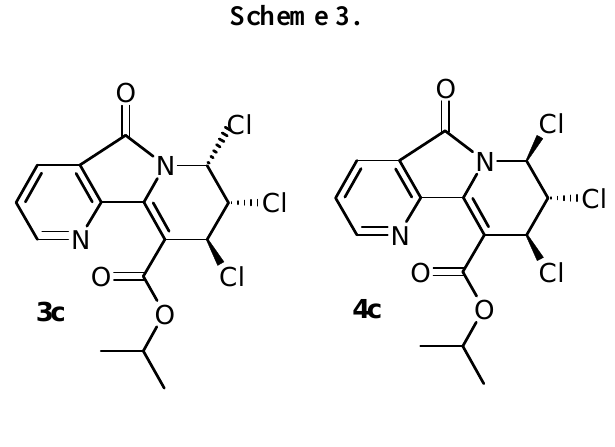
Table 2 . Comparative study of in vitro anti-tumour activity of diastereoisomers 3c and 4c (Scheme 3) against leukemia and non-small cell lung cancer cell